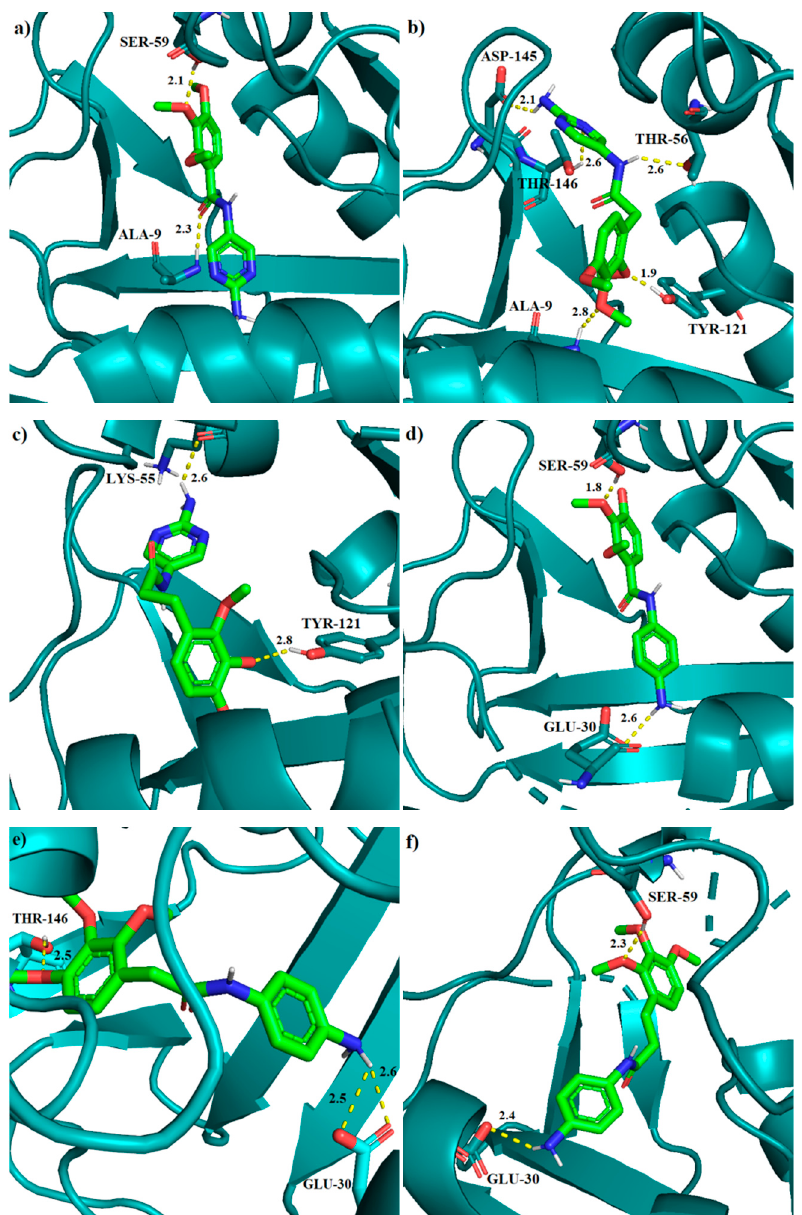
Figure 5. The binding modes of 1 ( a ), 2 ( b ), 3 ( c ), 4 ( d ), 5 ( e ), and 6 ( f ) in the active site of human DHFR. Hydrogen bond lengths in [Å].